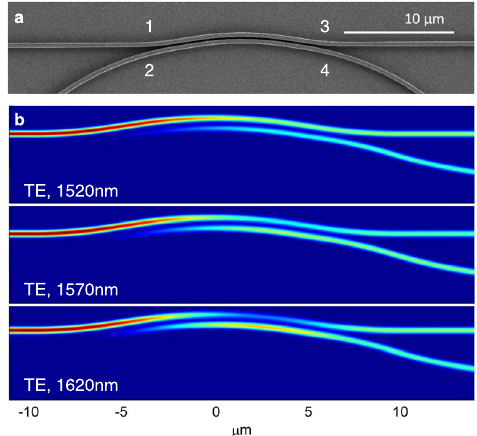
Figure 3. ( a ) SEM image of the fabricated device. ( b ) 3D FDTD simulated power distribution of the designed broadband 50/50 curved coupler for TE